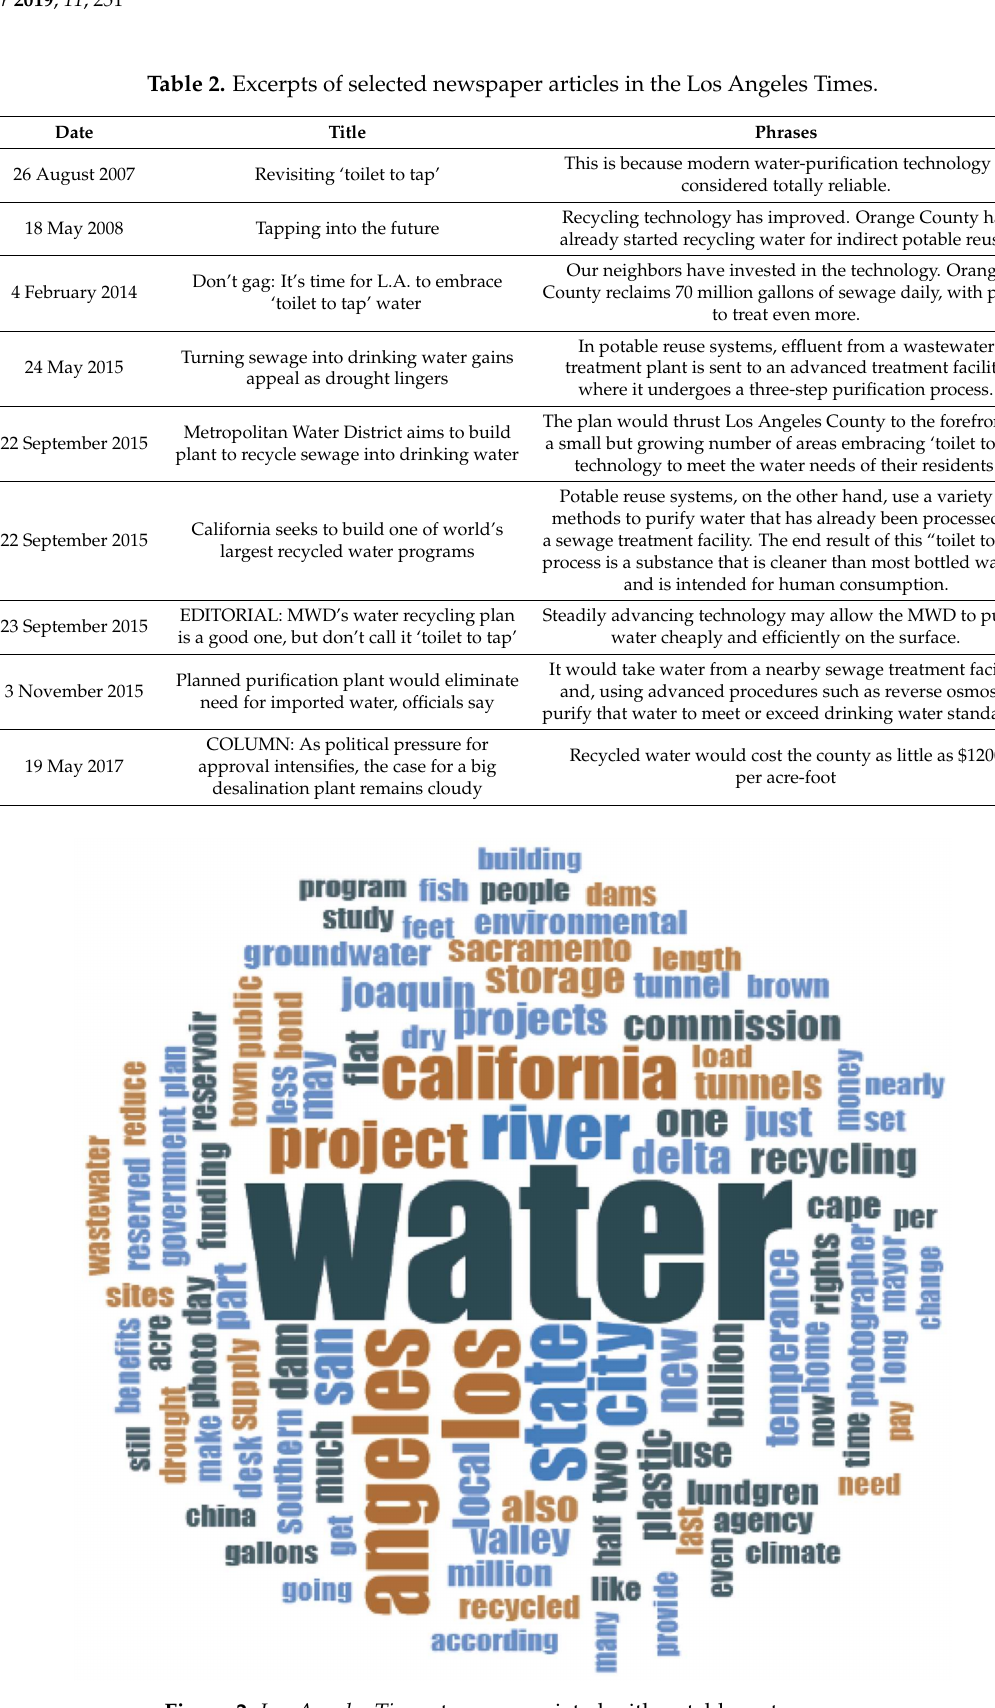
Figure 2. Los Angeles Times : terms associated with potable water